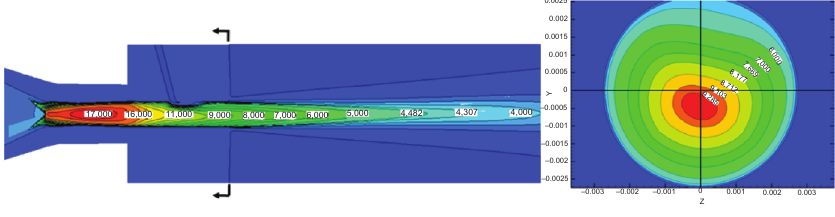
Figure 4: Temperature distribution of plasma jet in (a) axial direction and (b) radial direction at pure Ar.